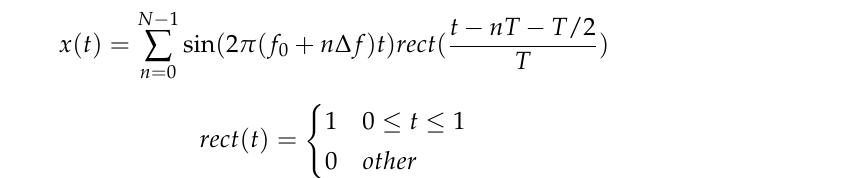
Figure 21. The polar pattern shows the comparison of radiation between the distance = 0.75 m and distance = 1.00 m. It is found out that the back-lobe level is different with the distance between the transmission antenna and receive antenna, and the back-lobe level of distance = 1.00 m is higher than that of distance = 0.75